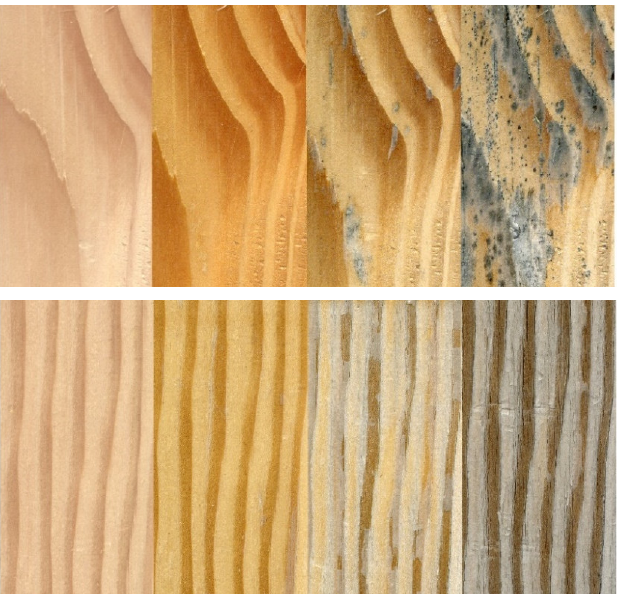
Figure 6. Examples of the same Douglas fir wood specimen treated with OM and exposed outdoors on a test fence near Corvallis, OR, for 0, 6, 12, and 18 months ( top row ) and a similarly treated specimen exposed in Madras, OR, for 0, 6, 15, and 25 months ( bottom row ).